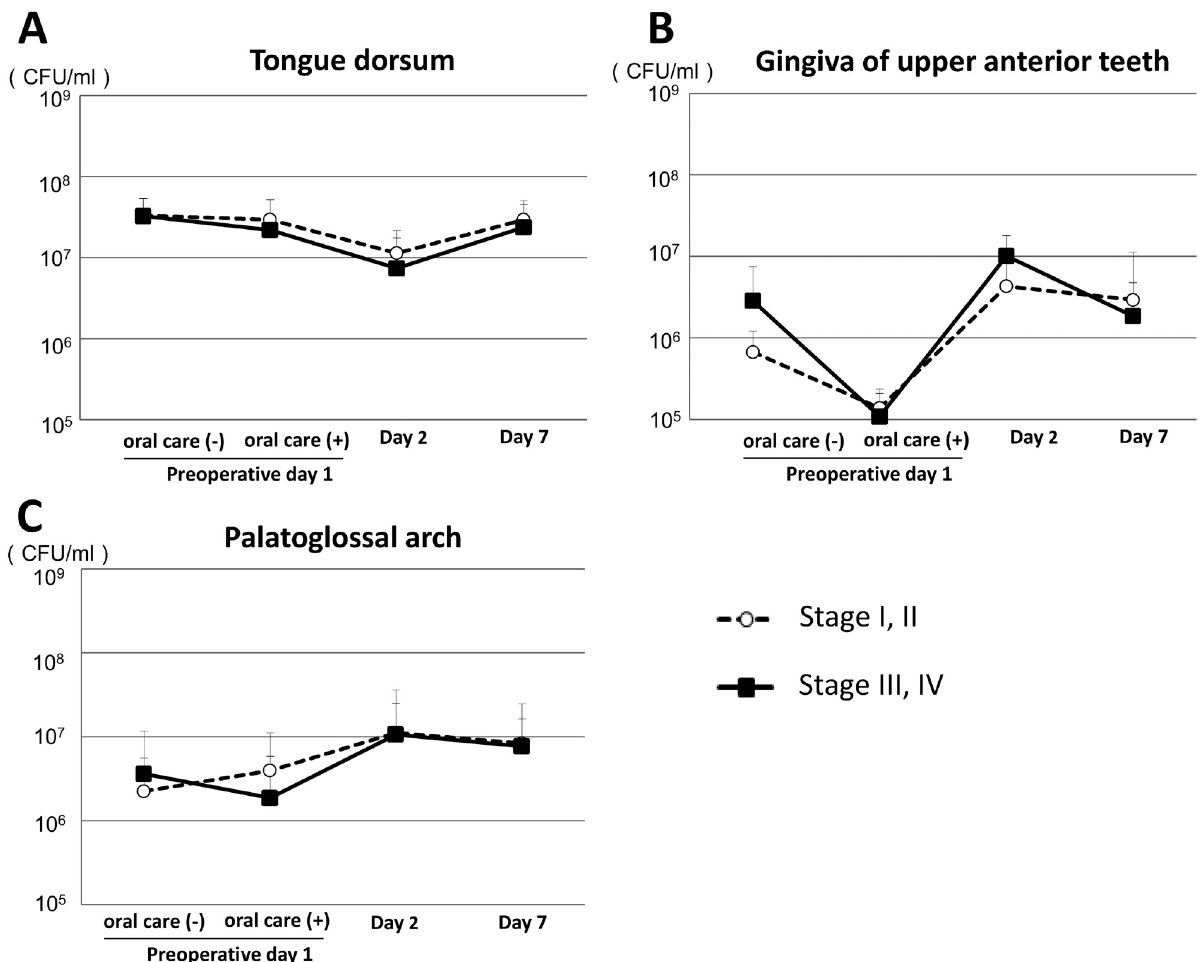
Figure 3- Comparison of oral bacterial counts between early and advanced tumor stage in laparoscopic surgery group. (A) Numbers of oral bacteria on the dorsum of the tongue. Error bars represent mean±SD; (B) Numbers of oral bacteria on the gingiva of upper anterior teeth; (C) Numbers of oral bacteria on the palatoglossal